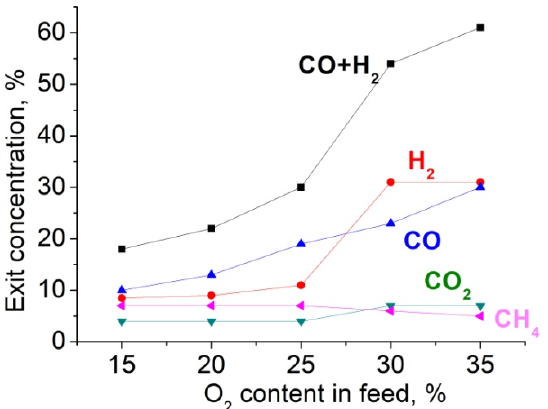
Figure 9. Dependence of products concentrations on oxygen content in the feed in the process of turpentine oil autothermal reforming on 3.4% LaNiPt/La-Ce-Zr-O/Fechraloy thin foil honeycomb